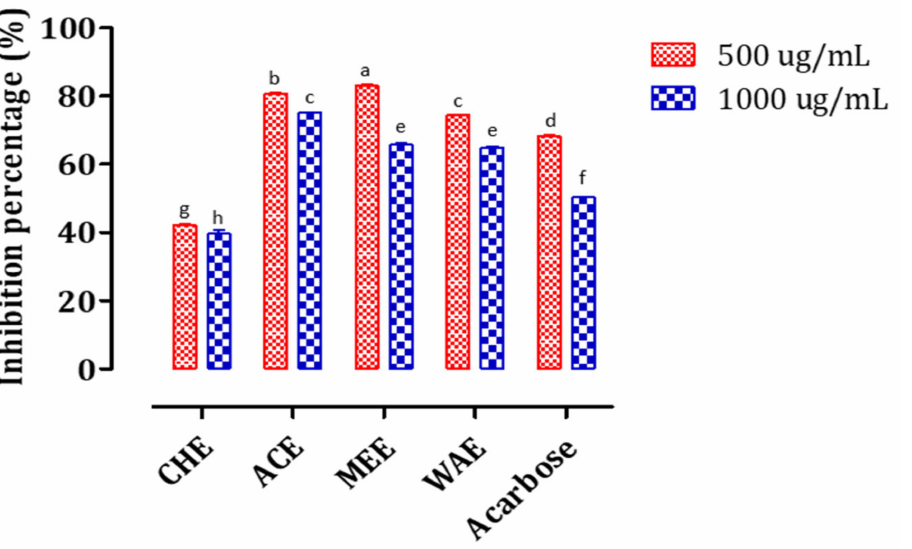
Figure 5. Inhibition of pancreatic α -amylase by P. granatum bark extracts and Acarbose at two concentrations (500 and 1000 µ g/mL). Different letters indicate significant differences at p <